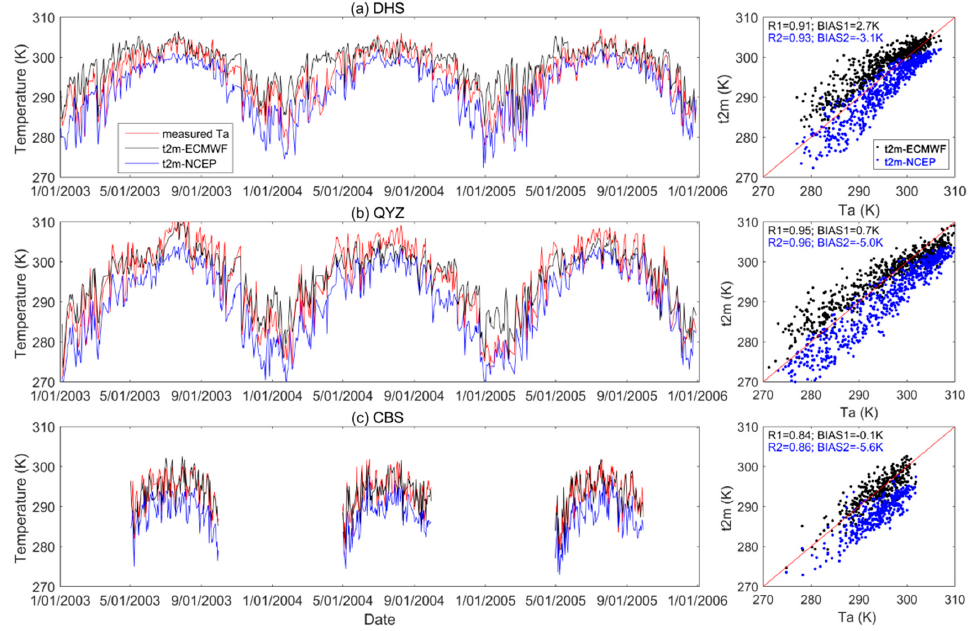
Figure 5. Time series and scatter plots of in-situ measured air temperature (Ta), 2-meter temperature from ECMWF reanalysis (t2m-ECMWF) and 2-meter temperature from NCEP reanalysis (t2m-NCEP). In-situ measurements at DHS, QYZ, and CBS are at 20 m, 23 m, and 26 m, respectively. In scatterplots, t2m-ECMWF and t2m-NCEP are marked by black and blue color, respectively. R1 represents the correlation coefficient (R) of in-situ Ta and t2m-ECMWF. R2 represents the R of in-situ Ta and t2m-NCEP. BIAS1 represents the difference between mean t2m-ECMWF and in-situ Ta. BIAS2 represents the difference between mean t2m-NCEP and in-situ Ta.